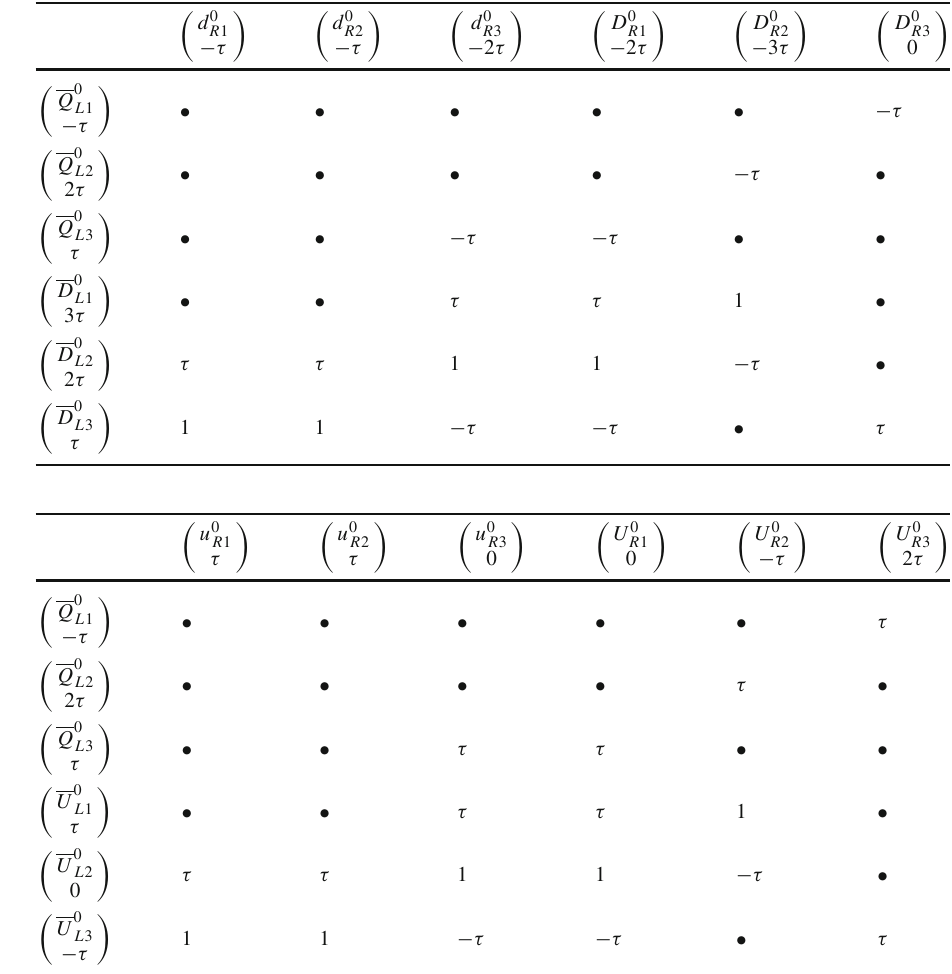
Table 1 Down sector, summary